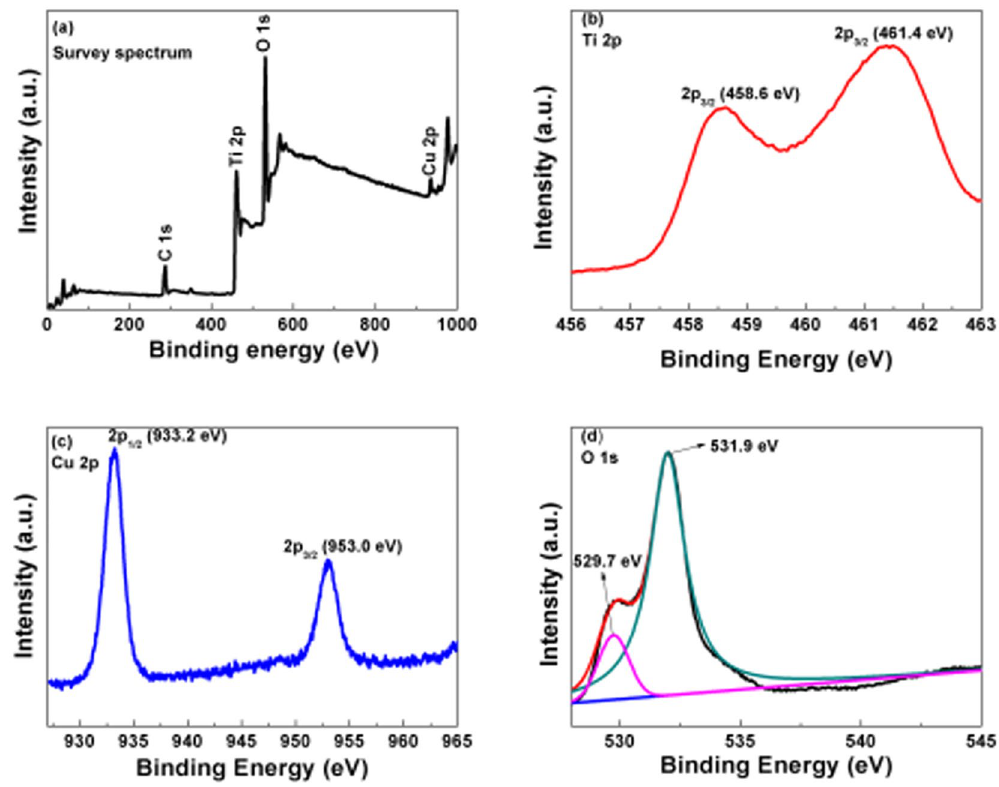
Figure 4. XPS spectra of S7: ( a ) Survey spectrum ( b ) Ti 2p, ( c ) Cu 2p, and ( d ) O